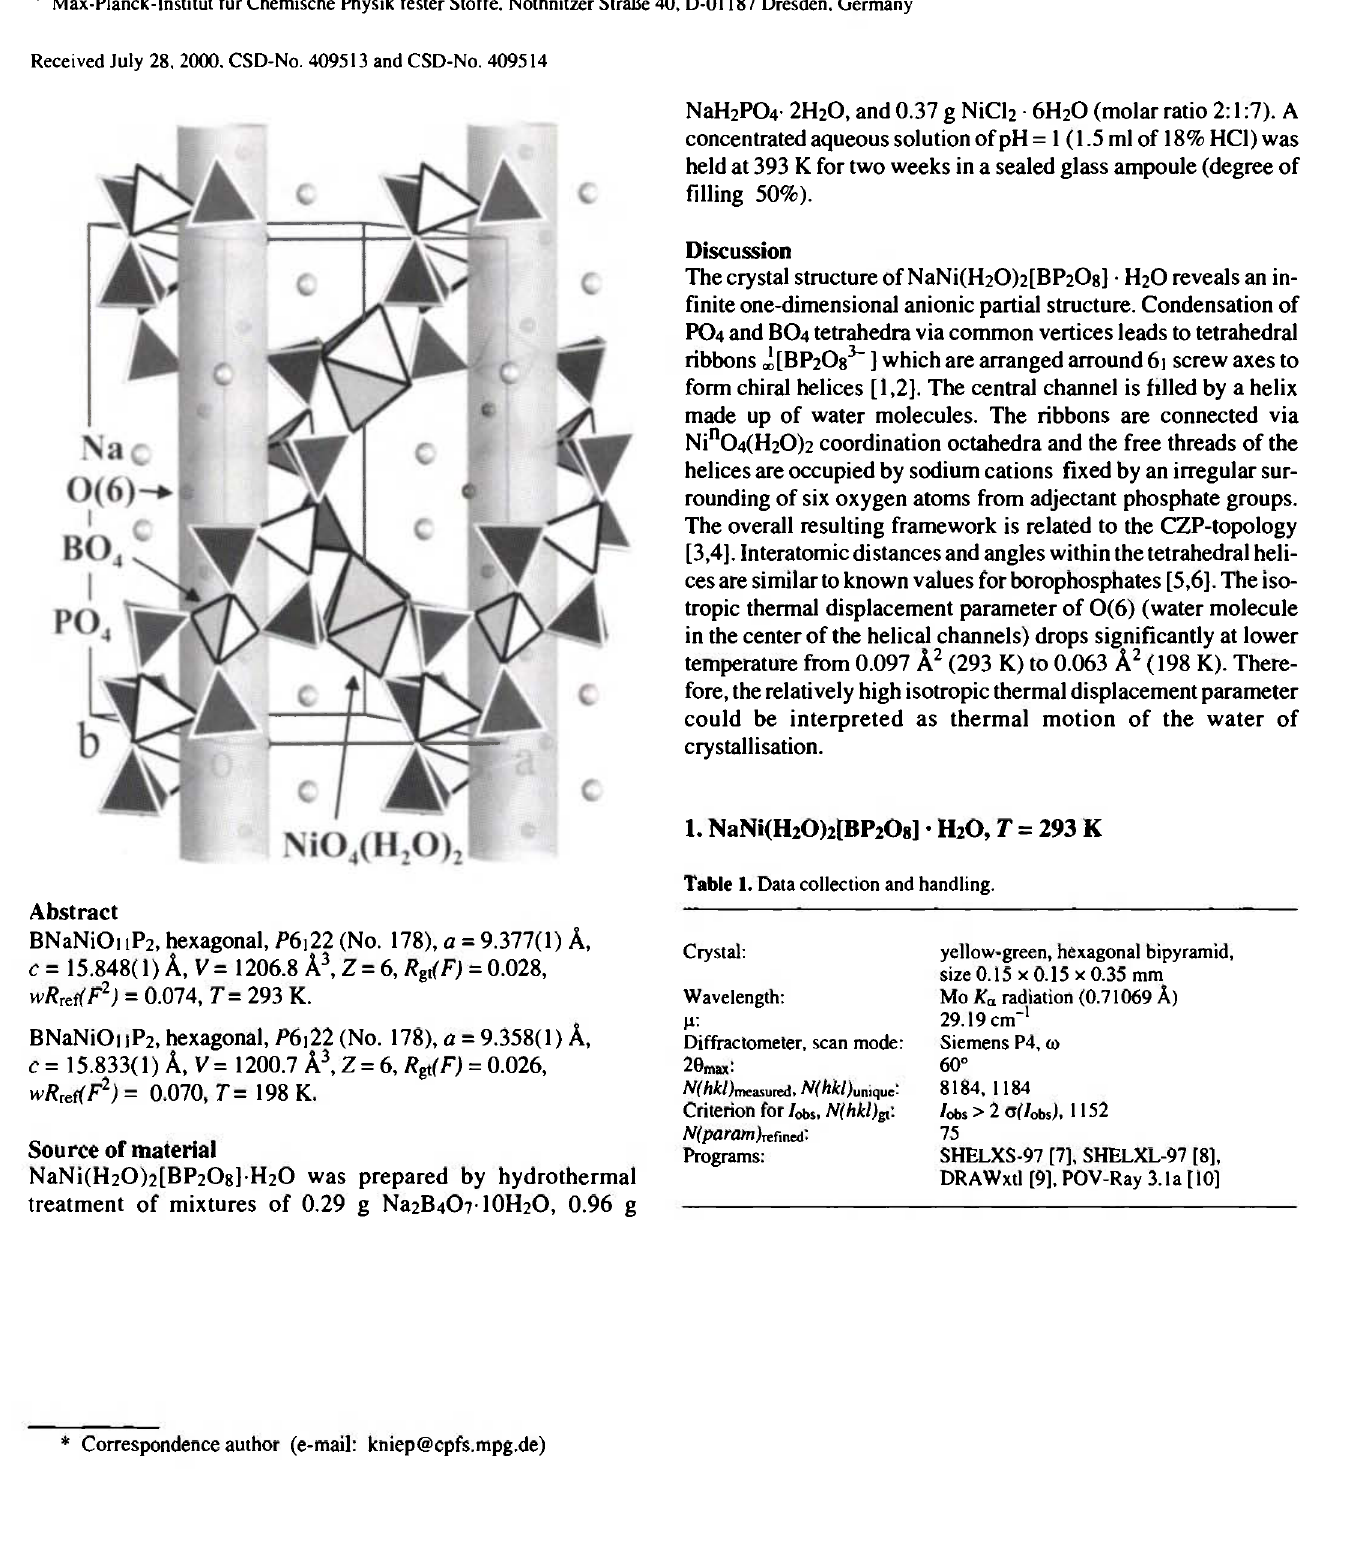
Table 1. Data collection and handling.